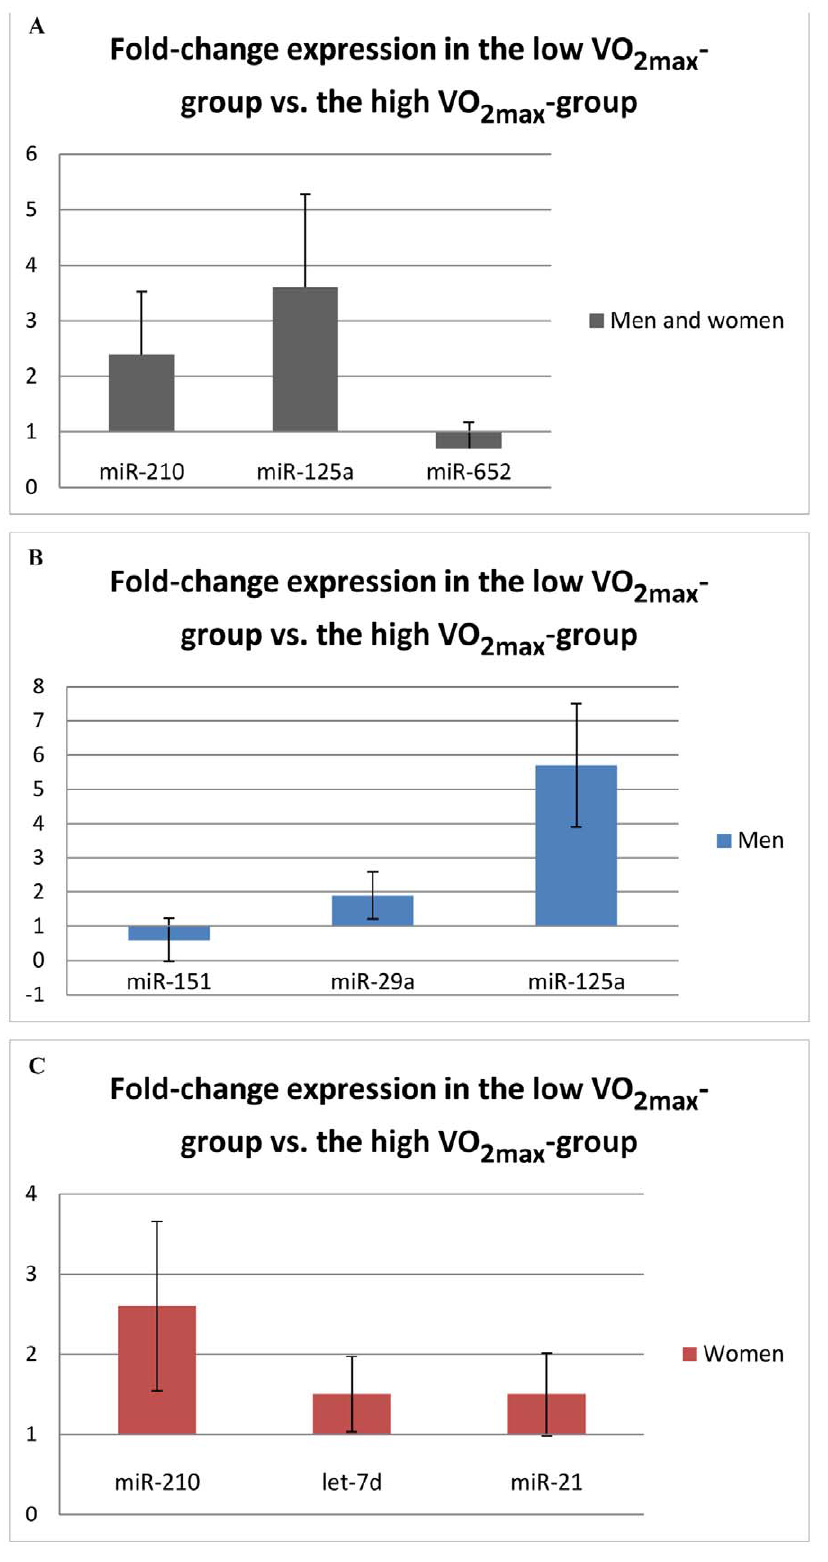
Figure 1. MicroRNAs with significantly different serum levels in individuals with high and low aerobic fitness in the screening cohort (p , 0.05). A: In both men and women (n=24), B: Men (n=12), C: Women (n=12). VO 2max : Maximal oxygen uptake. Error bars represent 1 standard deviation.